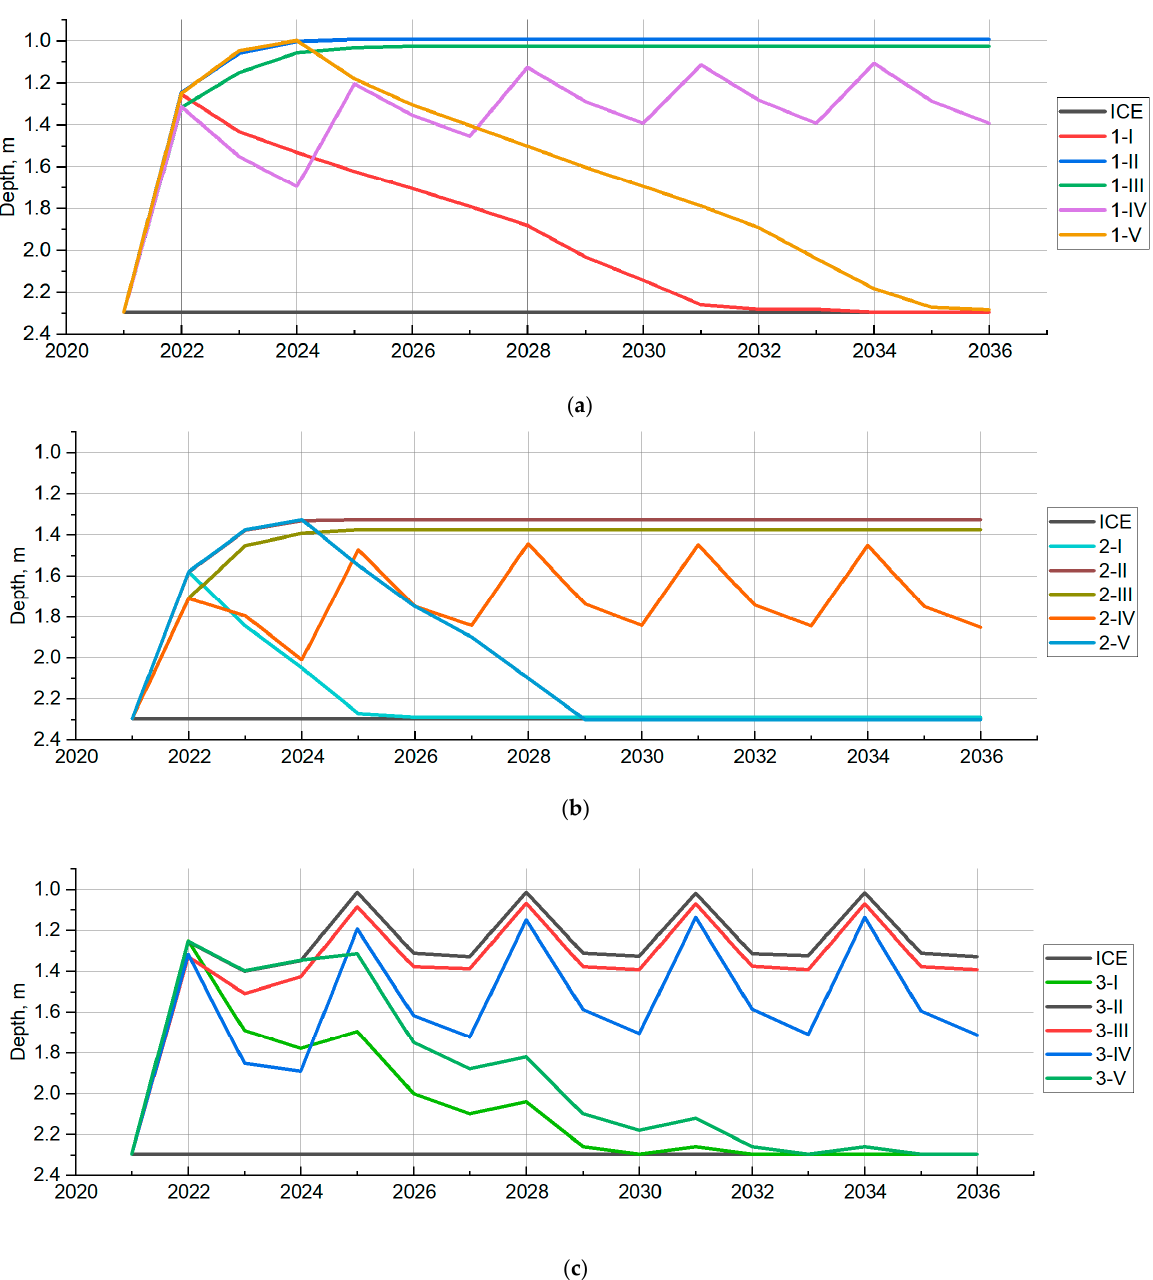
Figure 5. The simulated changes in thaw depth for three moisture variants with different snow scenarios. ( a )—variant 1; ( b )—variant 2; and ( c )—variant 3.